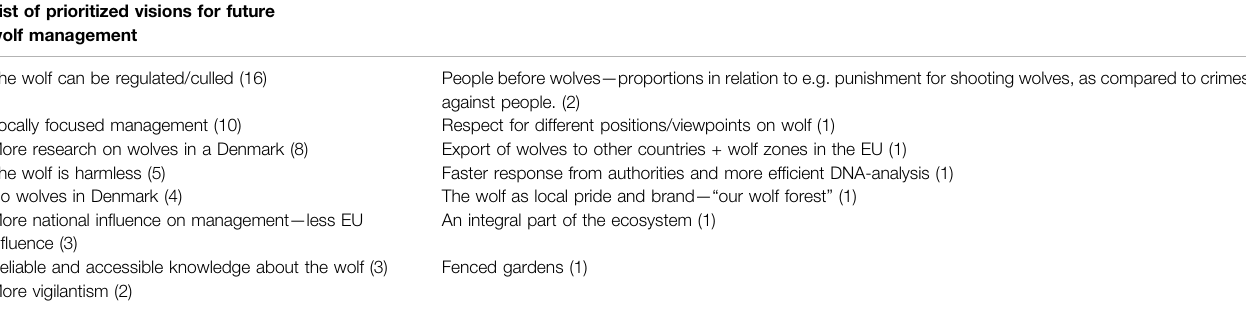
TABLE 3 | List of prioritized visions for an ideal future wolf management, as formulated by the participants in the WDP start-up phase, 2017. List of prioritized visions for future wolf